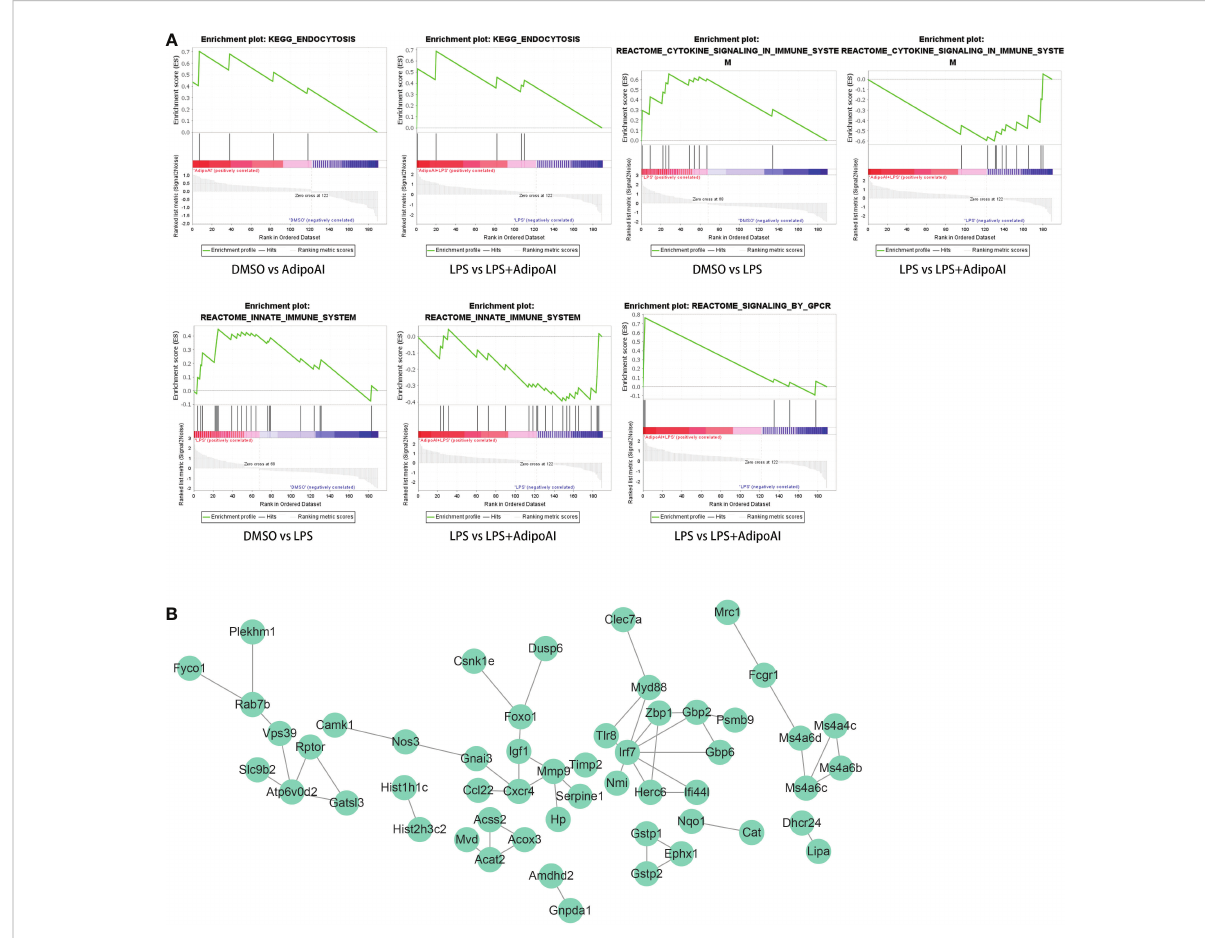
FIGURE 4 GSEA and PPI network for 190 DEmRNAs. (A) Gene set enrichment analysis of 190 DEmRNAs. (B) PPI network with 53 nodes and 53 edges of 190